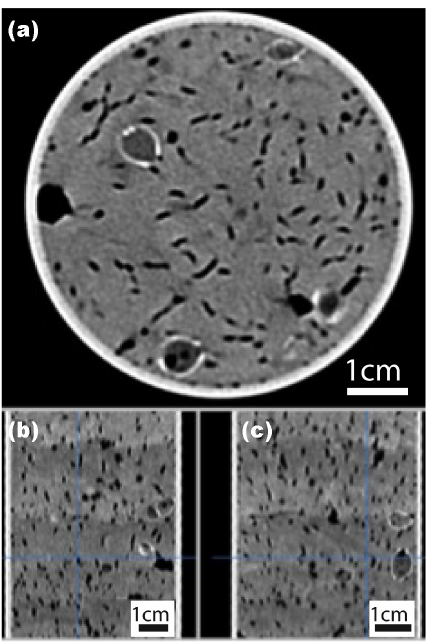
Figure 2. CT scan of a short core from Lake Wohlen (Wohlensee), Switzerland. The image courtesy of Hendrik Vogel and Flavio Anselmetti, and taken by Nicole Schwendener, was taken using the CT scanner at the Institute of Forensic Medicine, University of Bern. High-density bivalve shells appear as light, curved cross sec- tions, whereas low-density voids appear dark, and the homogenous sediment matrix is intermediate in tone. (a) Cross-sectional view of the core. (b) and (c) : lateral views of the